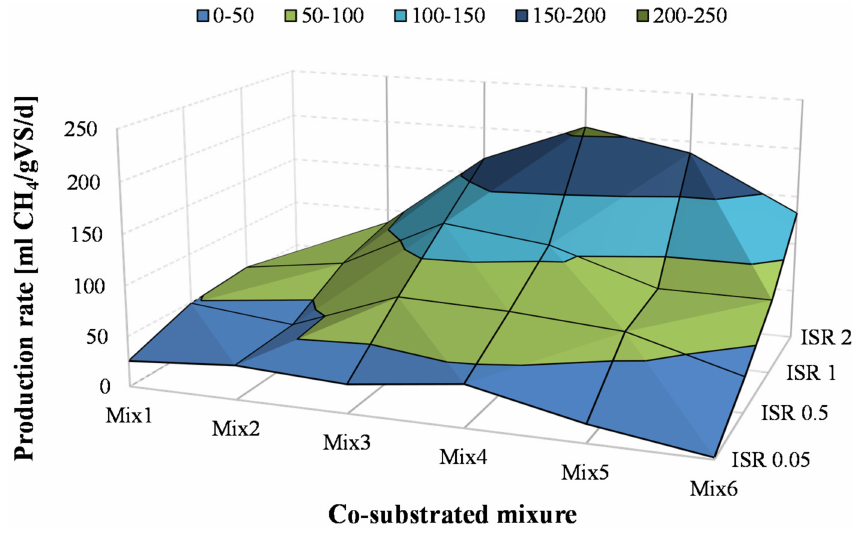
Figure 5. Methane production rates obtained in BMP